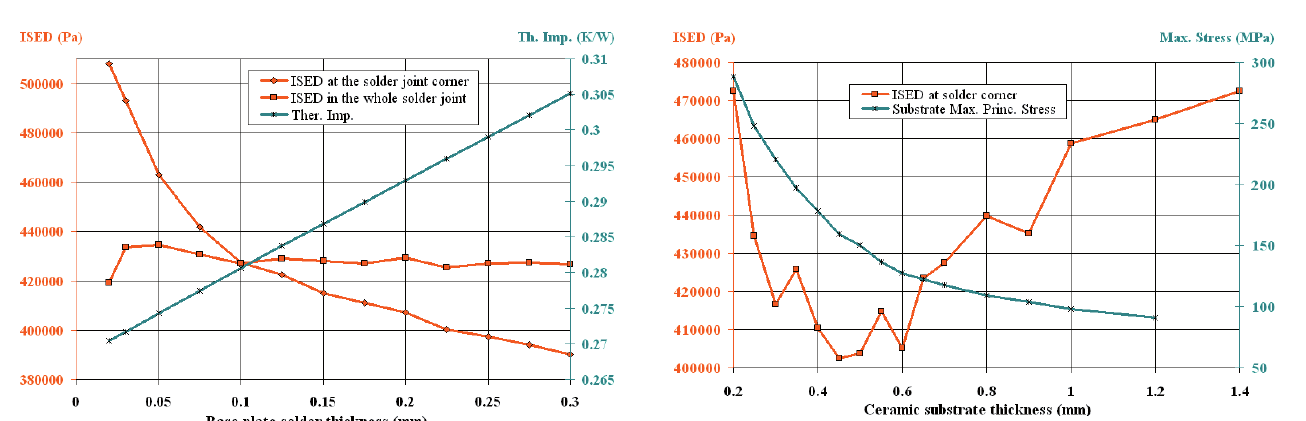
Fig. 26. Evolution of base plate solder corner ISED substrate maximal principal stress with substrate